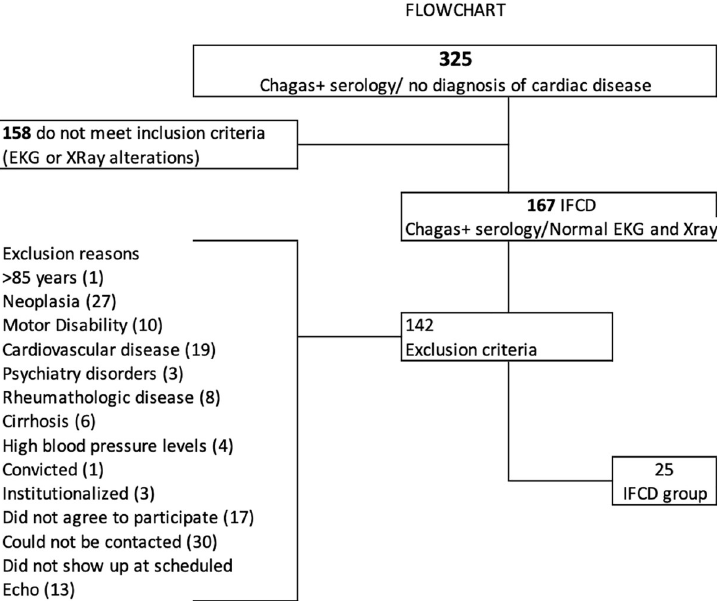
Fig 1. Flowchart of selection of Indeterminate Form Chagas Disease (IFCD) group of individuals with Chagas positive serologies.